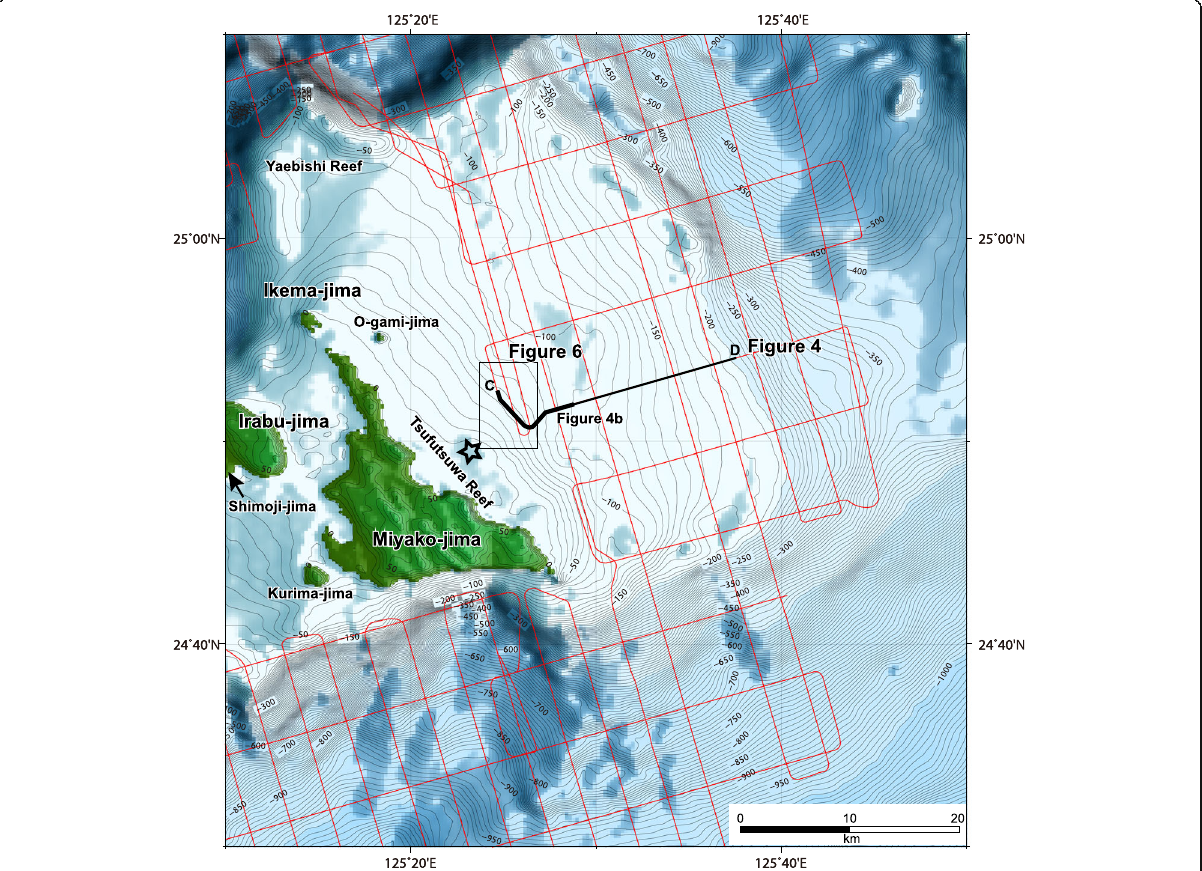
Fig. 2 Survey lines of the GH16 cruise focused on the eastern area off Miyako-jima. Submarine topographic relief data are from the JTOPO30v2 provided by the Marine Information Research Center, Japan Hydrographic Association. The topographic map is shaded from the northeast. Red lines are track lines of the GH16 cruise. The black line shows the location of Fig. 4. The bold black line shows the location where the mound- shaped structures are dominant as shown in Fig. 4b. The black box shows the area of Fig. 6. The star shows the location of the Tsufutsuwa